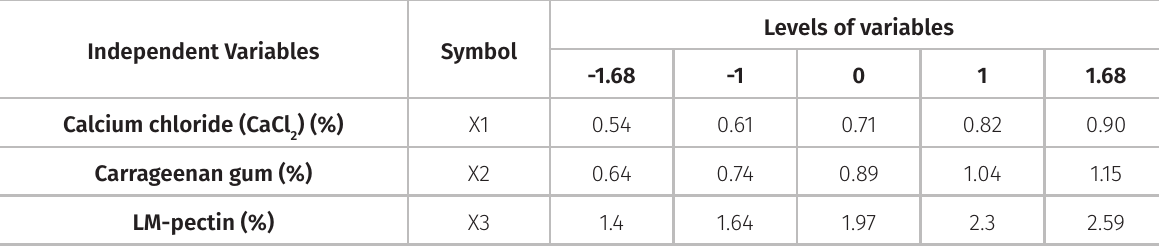
Table I. Complete factorial design 23 for the optimization of sugar-free banana preserves. Independent Variables Symbol Calcium chloride (CaCl ) (%) X1 2 Carrageenan gum